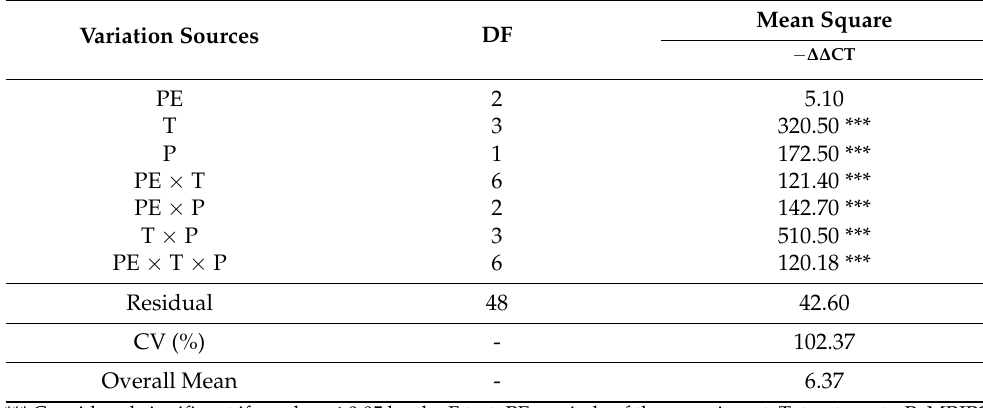
Figure 3. Boxplot of the variable 2 − ∆∆ CT between treatments. ( A ) MRJP3; ( B ) HSP70. BPF = basic protein feed; FPP = protein feed with prebiotics and probiotics. Table 2. Analysis of variance for the variable 2 − ∆∆ CT .